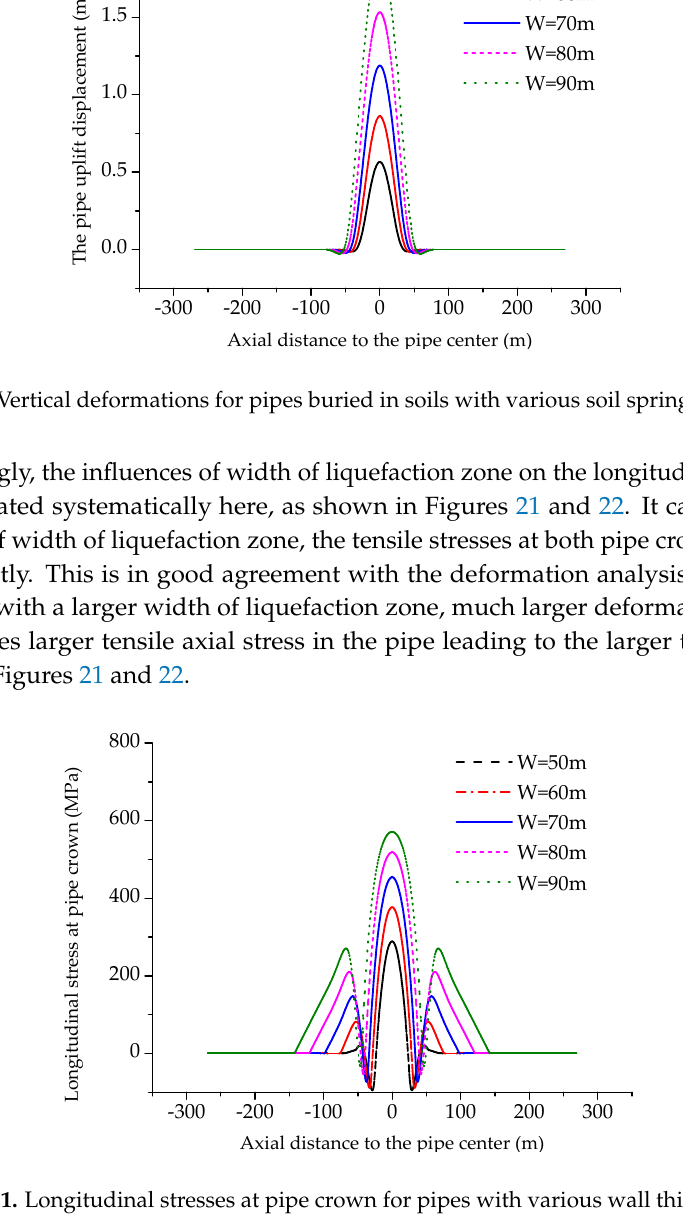
Figure 22. Longitudinal stresses at pipe invert for pipes with various wall thicknesses. 6. Conclusions A systematica analytical and numerical analysis of buried gas steel pipeline under buoyancy loads due to liquefied soil was performed in this study. A linear elastic model was chosen for the pipe steel, which makes this method mainly suitable for design purposes. Based on the governing equations of beams in bending and tension and beams on an elastic foundation, equations solving pipe deflection values, pipe internal moments and forces were derived. Deformation compatibility equations between pipeline physical elongation and pipeline geometrical elongation was also utilized to obtain the axial force on the pipe. By comparing the derived results of the proposed model with finite element model results for cases with various engineering parameters, the proposed analytical method has proven to be capable of accurately calculating pipe uplift displacements and stresses. Based on the established analytical model, parametric analyses were also conducted to derive how the common engineering parameters influences a pipe’s mechanical behaviors. Results show that smaller pipe diameter can lead to larger uplift displacement and result in larger longitudinal stresses in pipe, especially the large tensile stresses at the center and edge of pipe segment in liquefaction